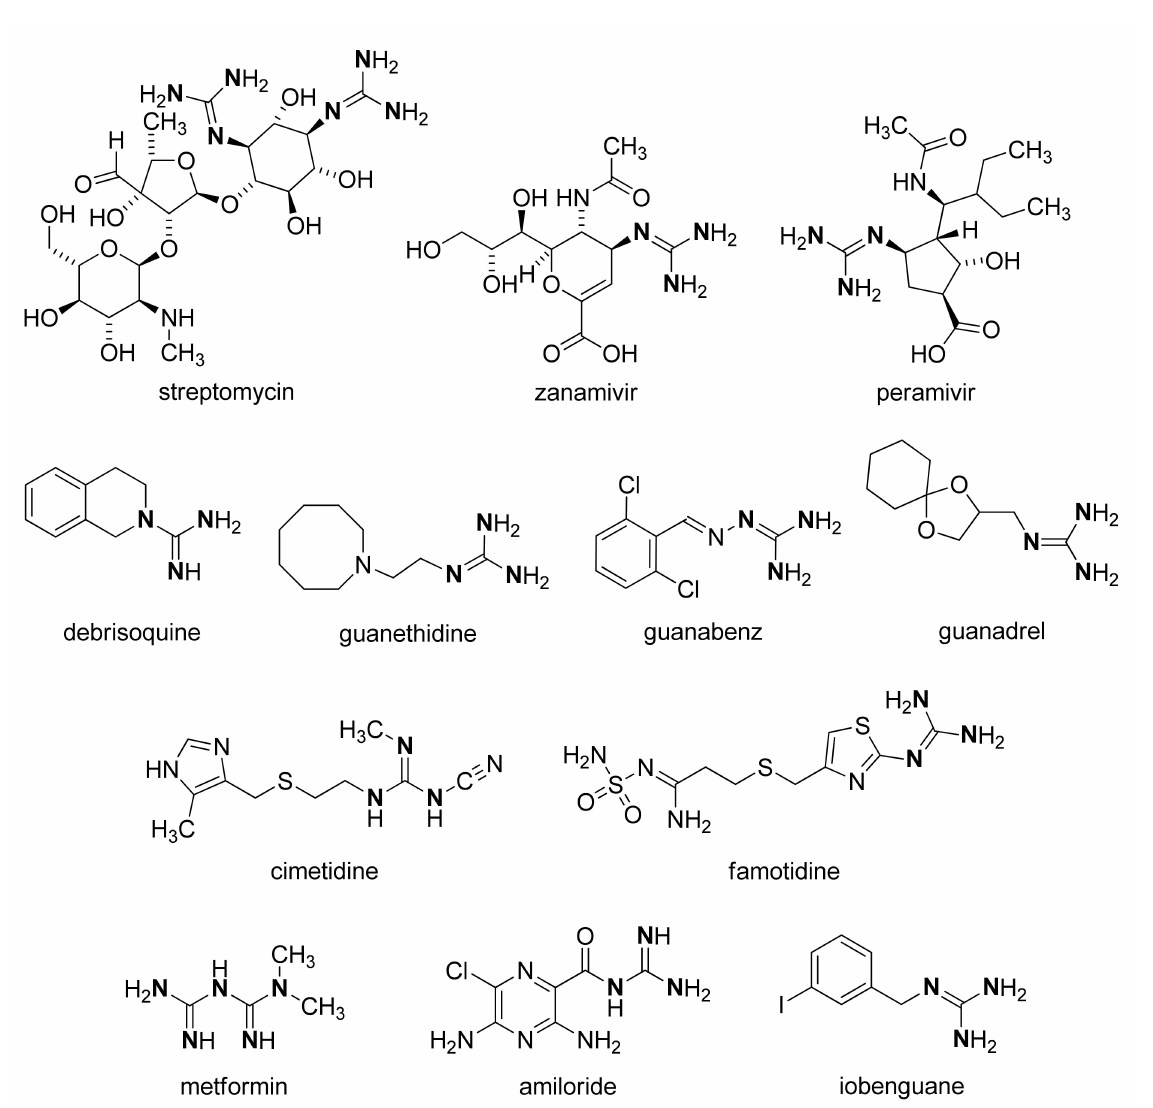
Figure 1. Chemical structures of guanidine containing